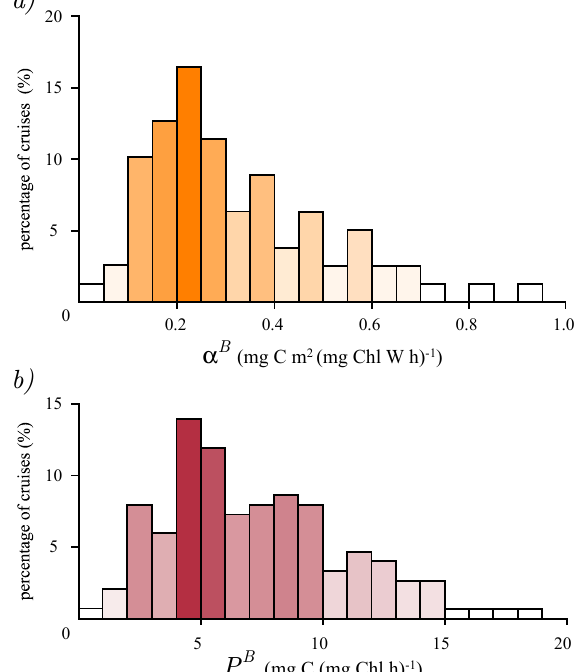
Figure 1. Histograms of estimated parameter values: ( a ) distribution of the initial slope, α B , obtained from 87 cruises and ( b ) distribution of the assimilation number, P B m , obtained from 138 cruises. The abscissa corresponds to the parameter values and the ordinate gives the percentage of cruises that fell into a certain interval of parameter